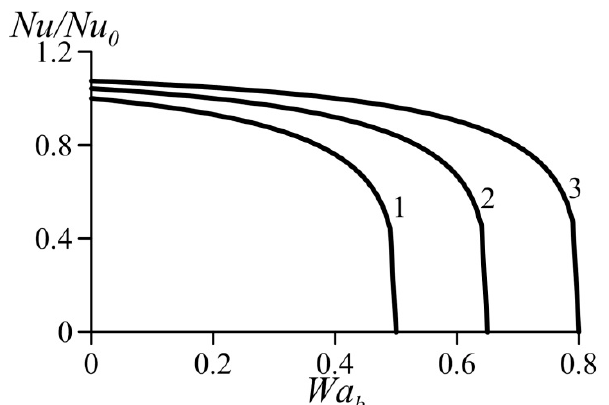
Figure 5. Effect of van der Waals number Wa a on the normalized Nusselt number under condition Wa b = const. 1— Wa b = 0, 2— Wa b = 0.1, 3— Wa b = 0.2.